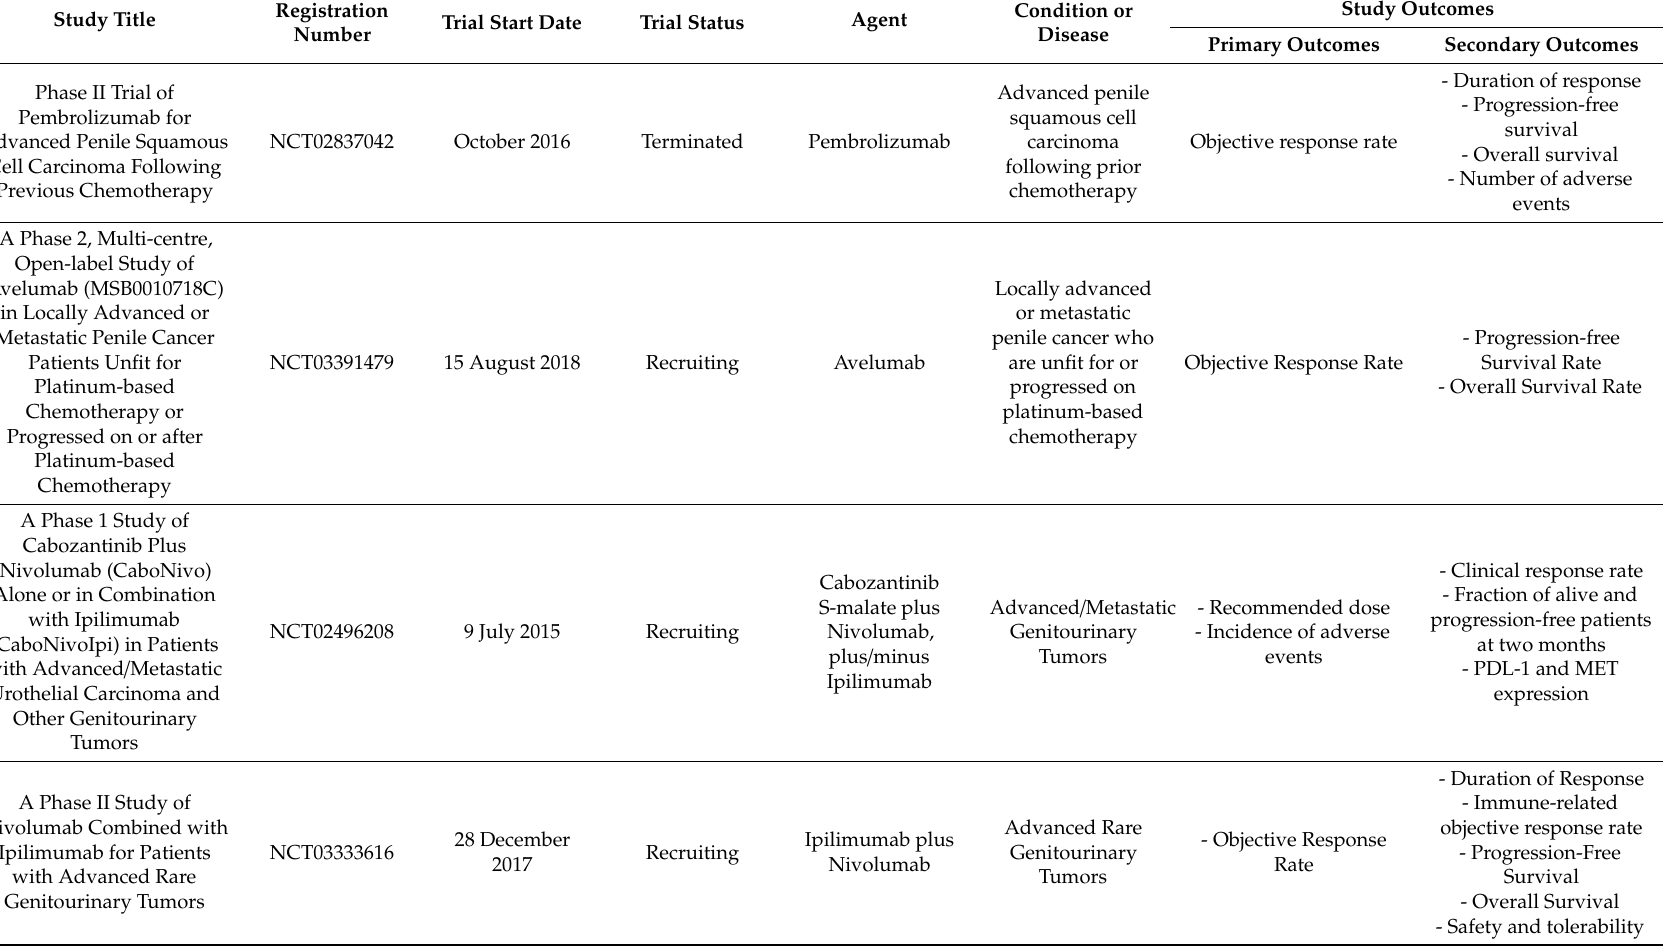
Table 1. Recent and ongoing immunotherapy clinical trials in penile